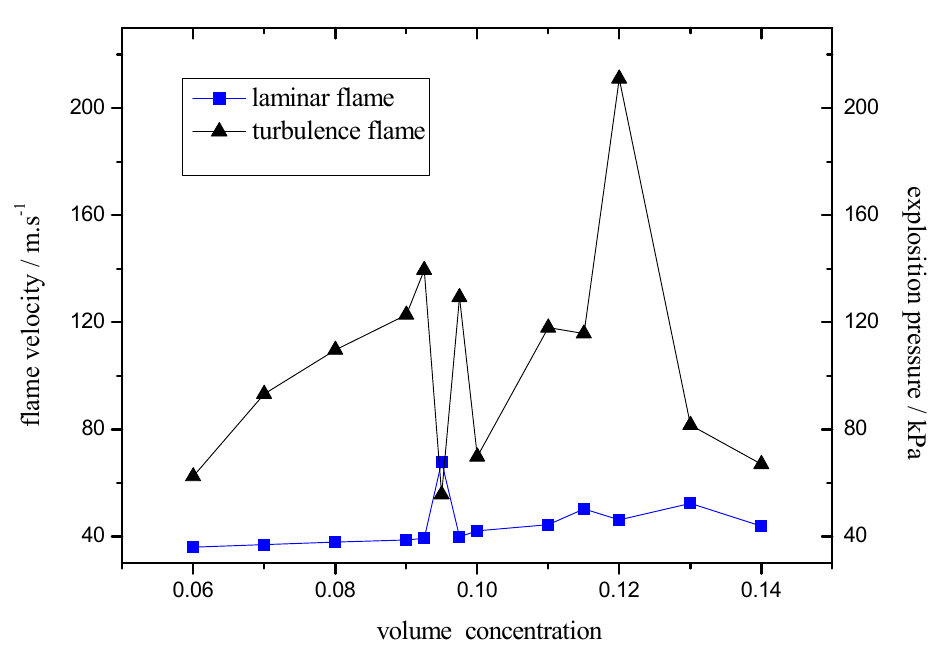
Figure 3. Flame velocity vs . volume concentration.